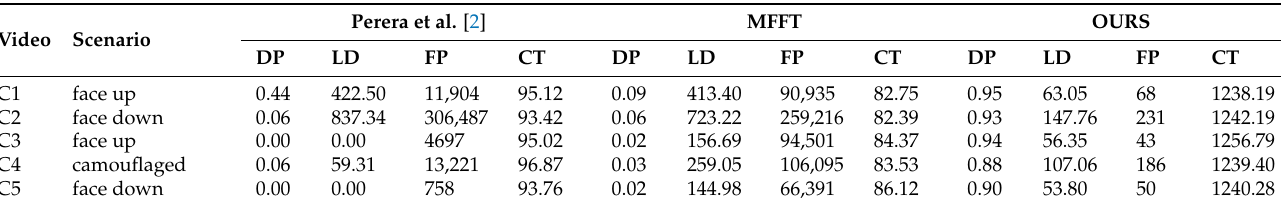
Table 5. Results of detection precision DP , location density LD ( ‰ ) , number of false detected points FP and computational time CT ( s ) of Perera et al.’s work [2], MFFT and ours for five camera videos.